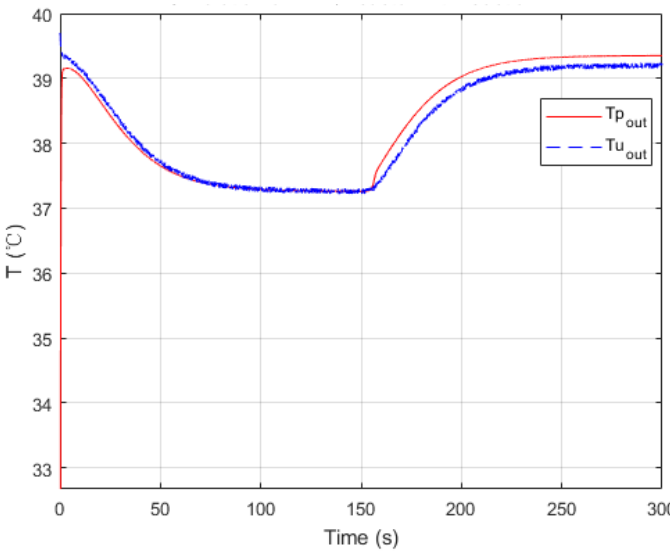
Figure 14. Simulated temperature profiles for experiment 1 (reaction was introduced at 150 s).